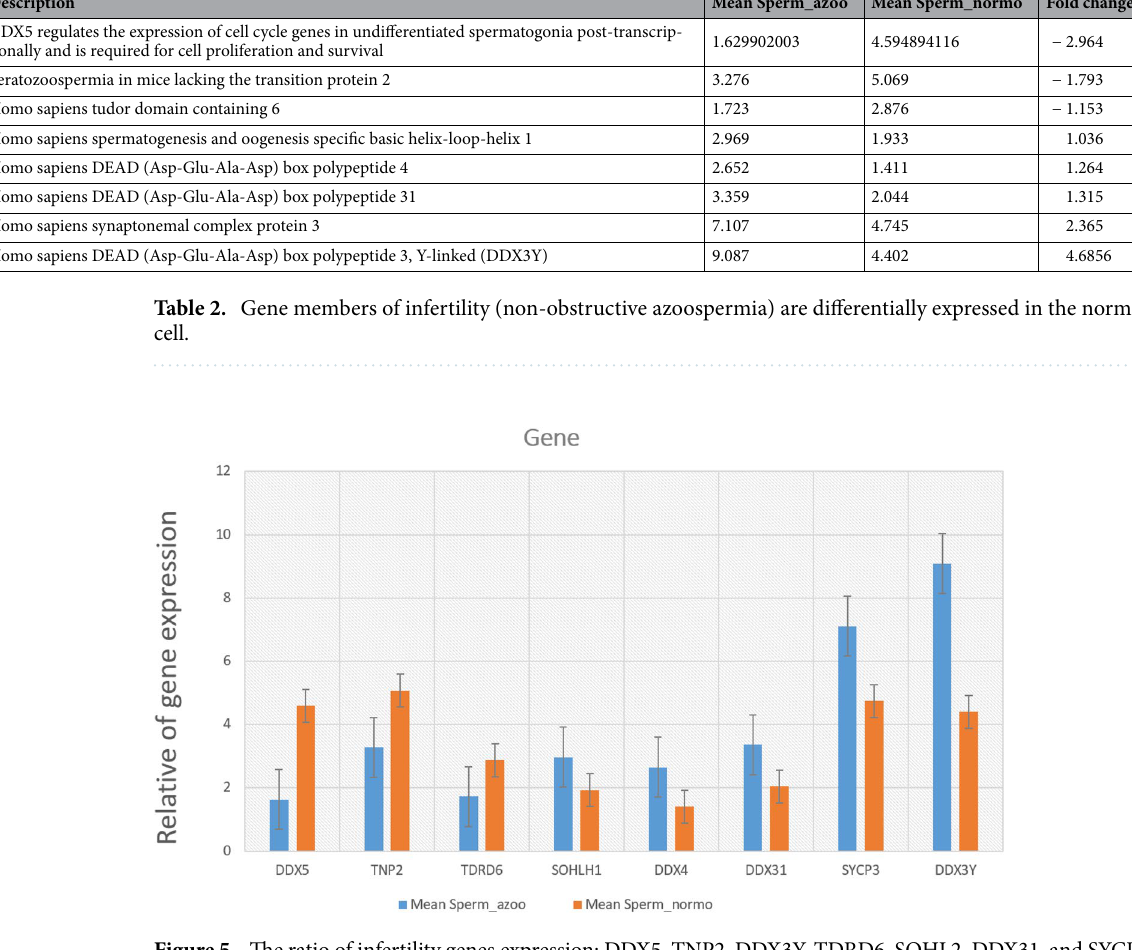
Figure 5. The ratio of infertility genes expression: DDX5, TNP2, DDX3Y, TDRD6, SOHL2, DDX31, and SYCP3 in infertility cell (azoospermia) in comparison to a normal cell. There is a significant decrease in gene expression of DDX5, TNP2, and TDRD6 and an increase in DDX3Y, SOHL2, DDX31, and SYCP3 compared to a normal